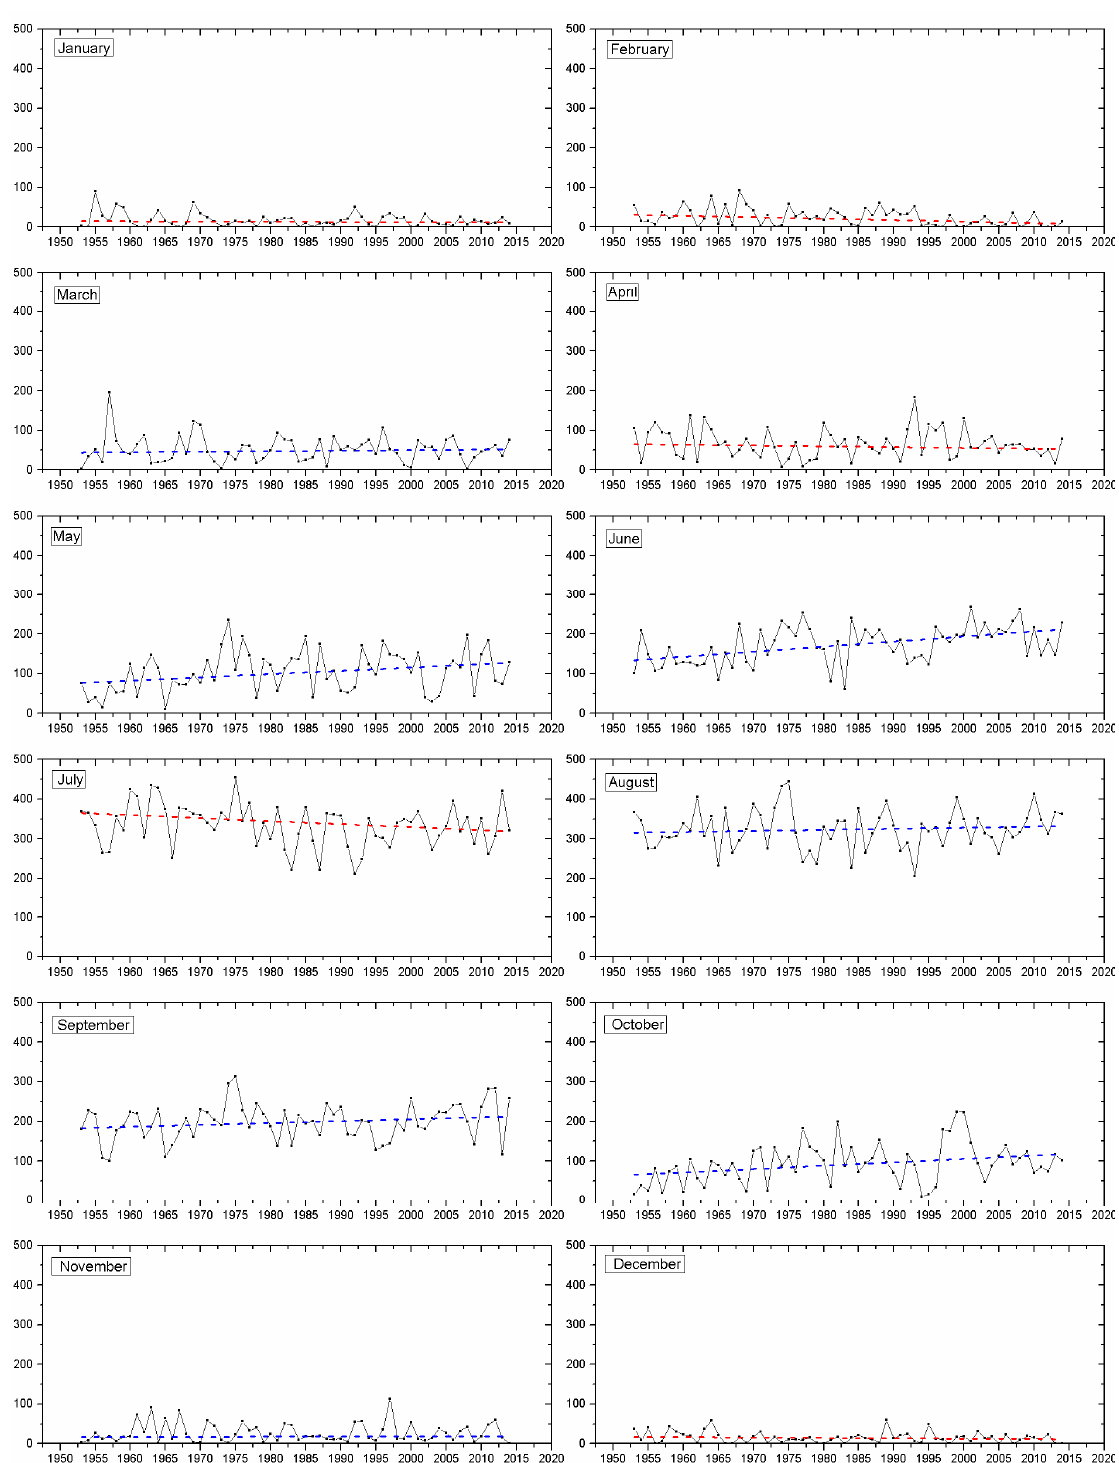
Figure 7. Time series plot for the monthly-averaged rainfall for UBNB. The dashed line indicates the Sen’s Slope trend line. Y-axis represents averaged monthly rainfall (mm).